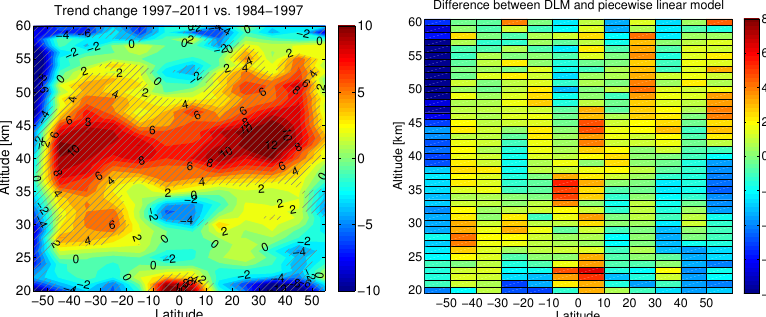
Figure 9. To compare DLM results to linear regression analysis in Kyrölä et al. (2013) we reproduce its Figure 16 by using the DLM approach. The left panel shows the change in ozone trends in % per decade between the periods 1997–2011 and 1984–1997. The shaded area indicate regions where the trend difference is nonzero with over 95% posterior probability. The right panel shows the differences (in %decade − 1 ) between the numbers that produce the contour plot on the left panel and the corresponding one in Kyrölä et al. (2013) (Fig. 16).